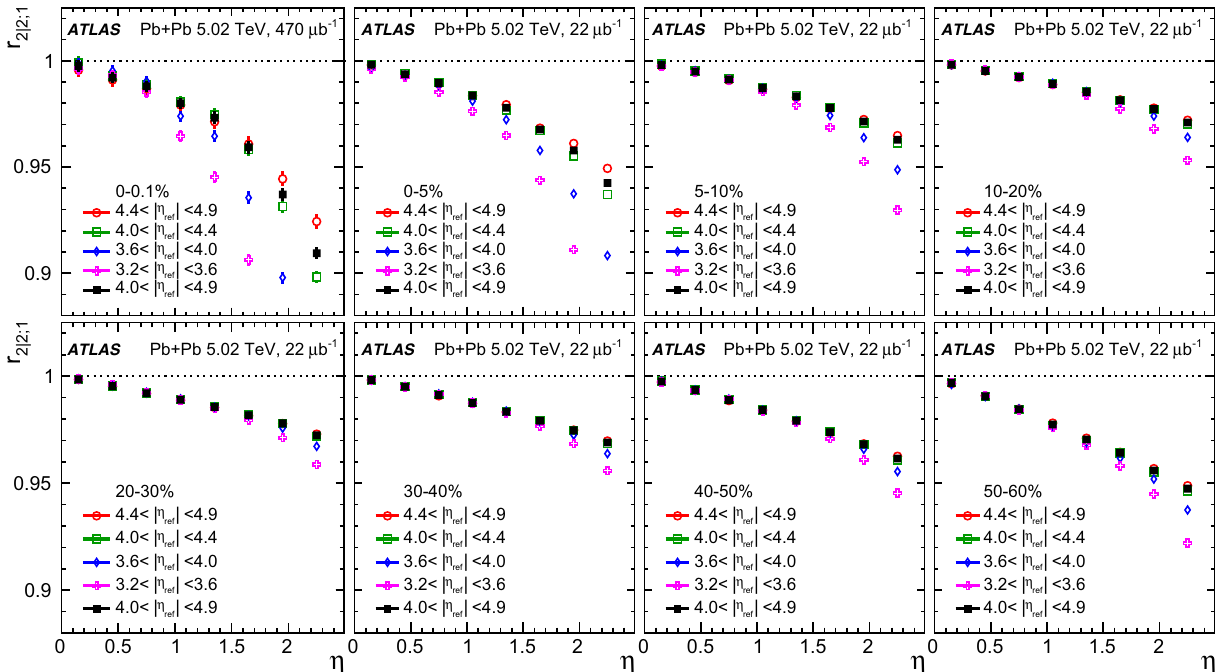
Fig. 2 The r 2 | 2 ; 1 (η) measured for several η ref ranges. Each panel shows the results for one centrality range. The error bars are statistical